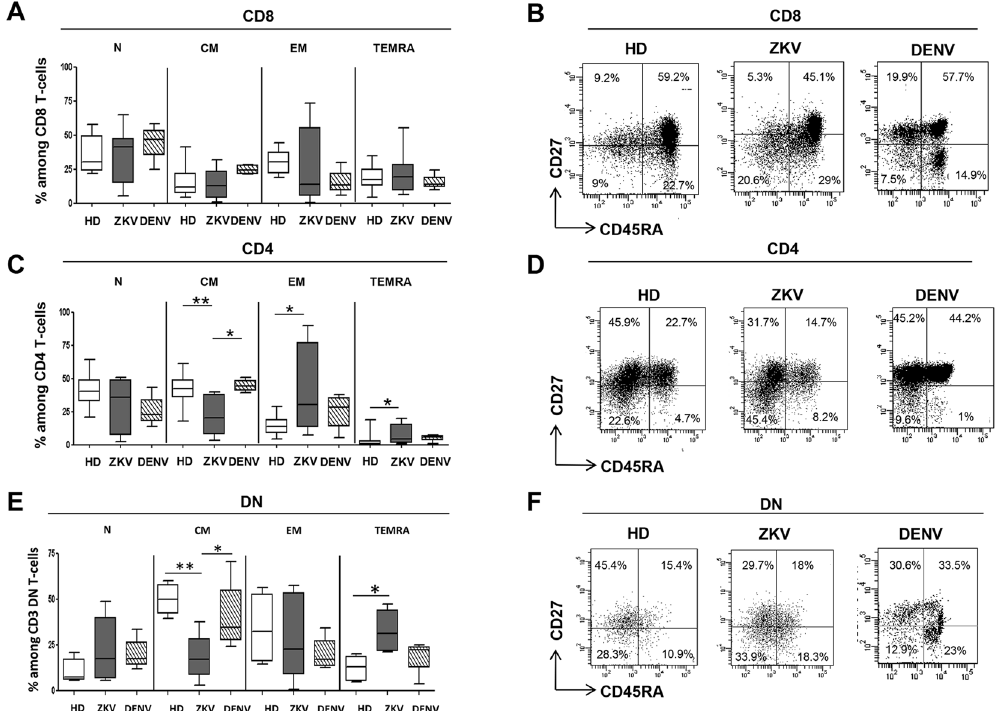
Figure 3. Differentiation profile of CD8, CD4 and DN T-cells during ZIKV infection. The frequency of naive (N, CD45RA pos CD27 pos ), central memory (CM, CD45RA neg CD27 pos ), effector memory (EM, CD45RA neg CD27 neg ) and terminally differentiated (TEMRA, CD45RA pos CD27 neg ) CD8 + ( a ), CD4 + ( b ) and DN ( c ) T-cells was analyzed by flow cytometry in HD (white bars), ZIKV (grey bars) and in DENV (hatched bars). * p < 0.05; ** p <